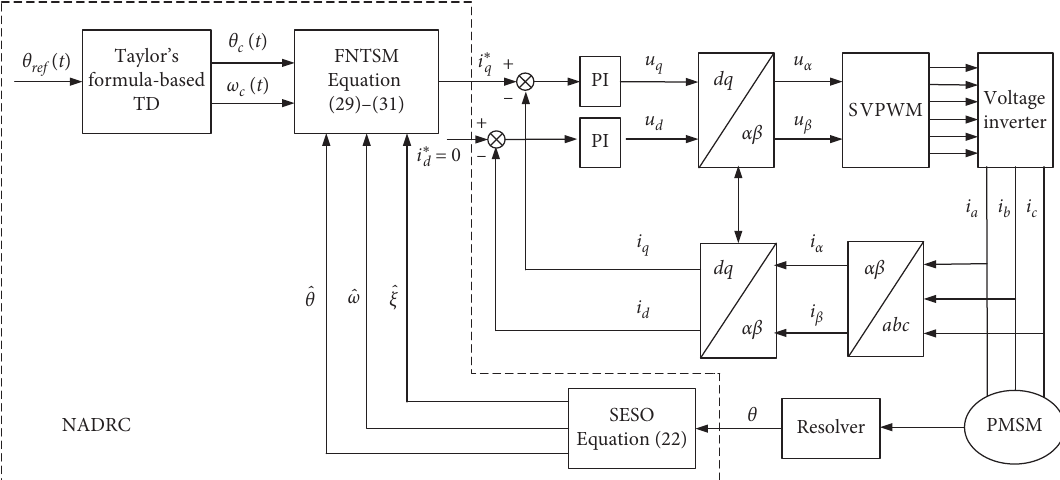
Figure 2: Structure of the PMSM drive in the rocket launcher servo system.